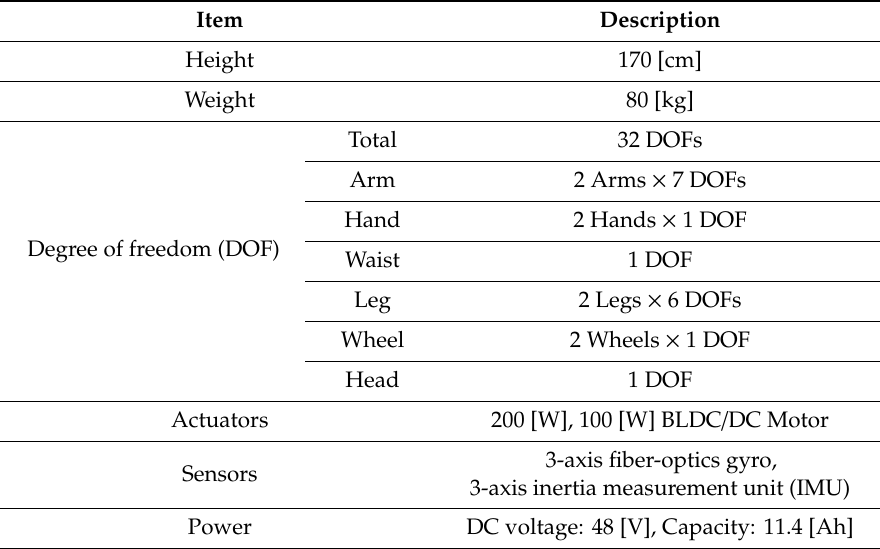
Table 1. Specification of DRC-HUBO +